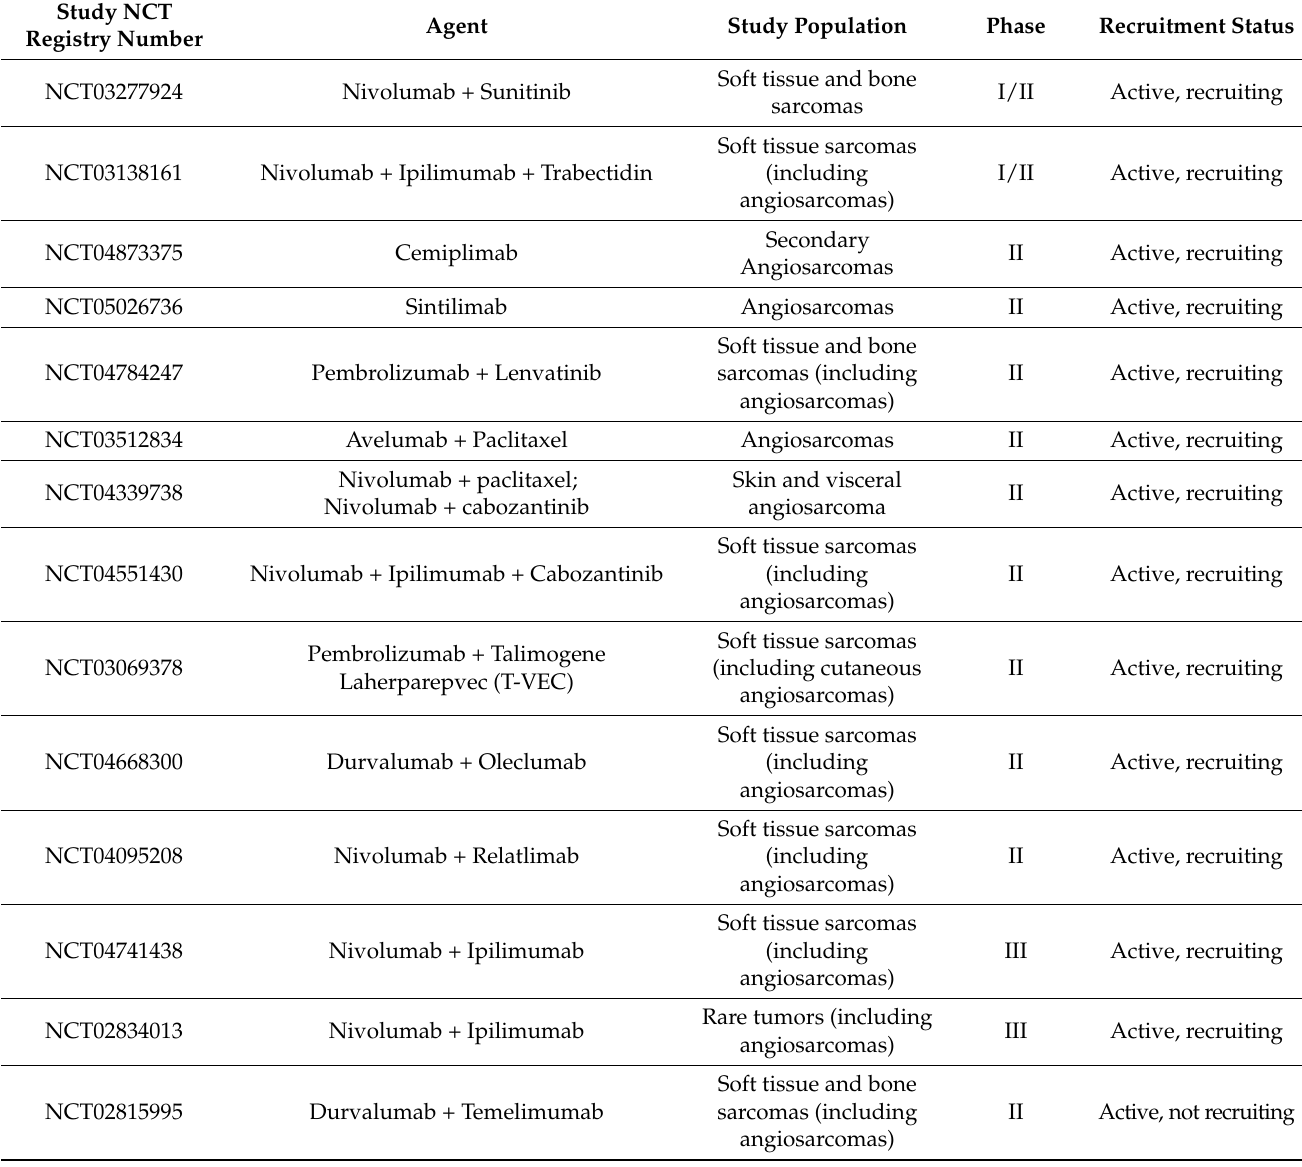
Table 4. Main ongoing clinical trials evaluating ICI in Angiosarcoma